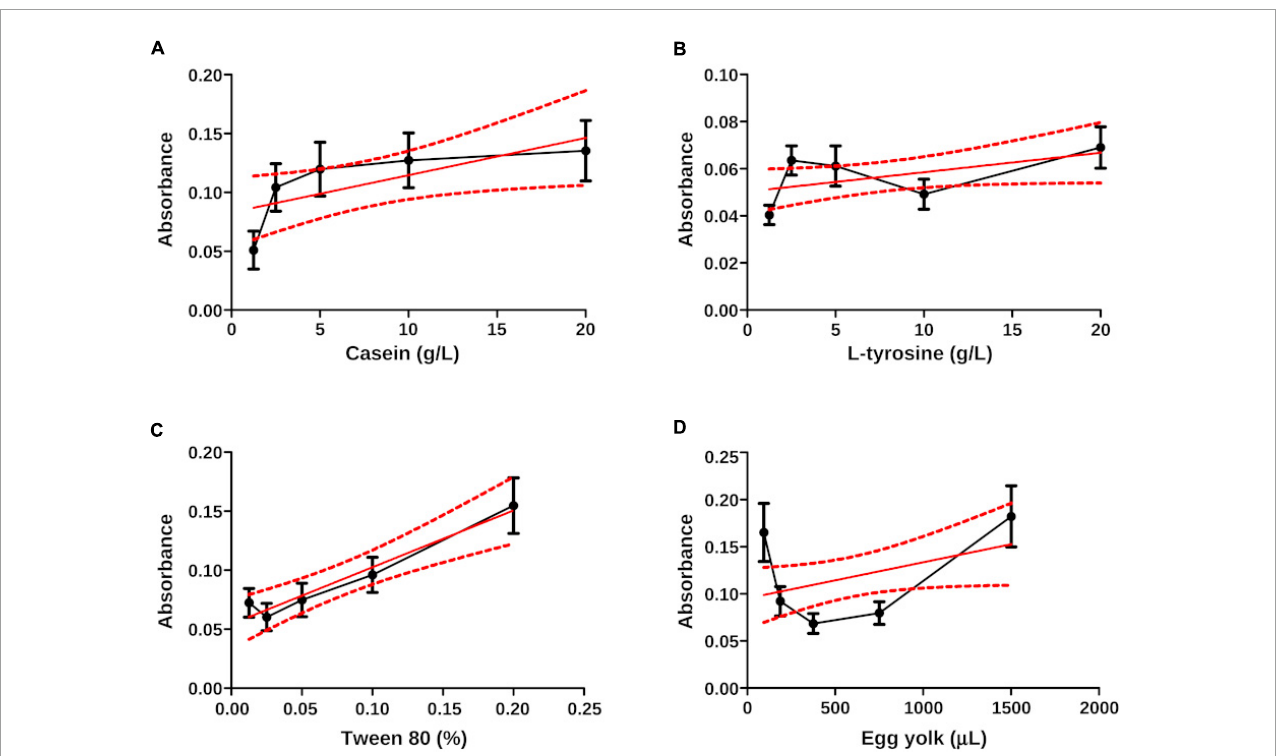
FIGURE7 Linear regression plots (x, y) of the interpolated data of N. brasiliensis on the calibration curve. (A) Casein did not show a linear relation even when the values were within the control limits (dotted lines in red). The r 2 value was 0.70. (B) The zigzagging behavior in L-tyrosine did not show linear regression, r 2 was 0.67. (C) The first plotted data prevented by Tween 80 showed a linear regression also affected by correlation, the r 2 was 0.69. (D) The curve relation in egg yolk exceeded the control limits, the r 2 was 0.73. The plots were generated in GraphPad Prism